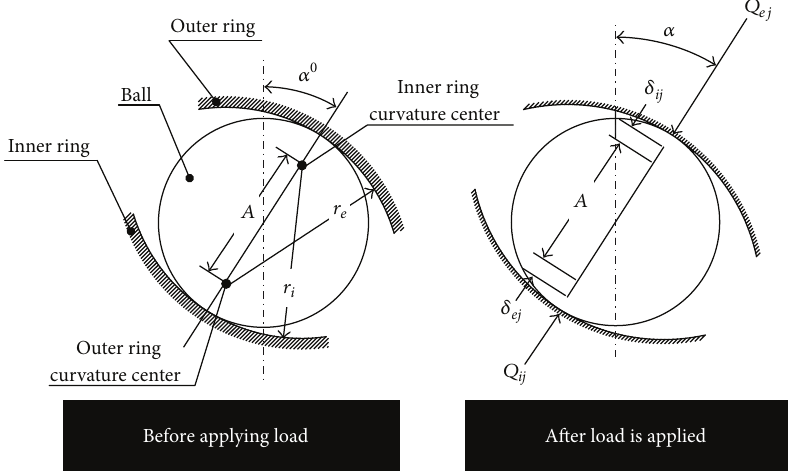
Figure 1: Relationship between normal contact load and